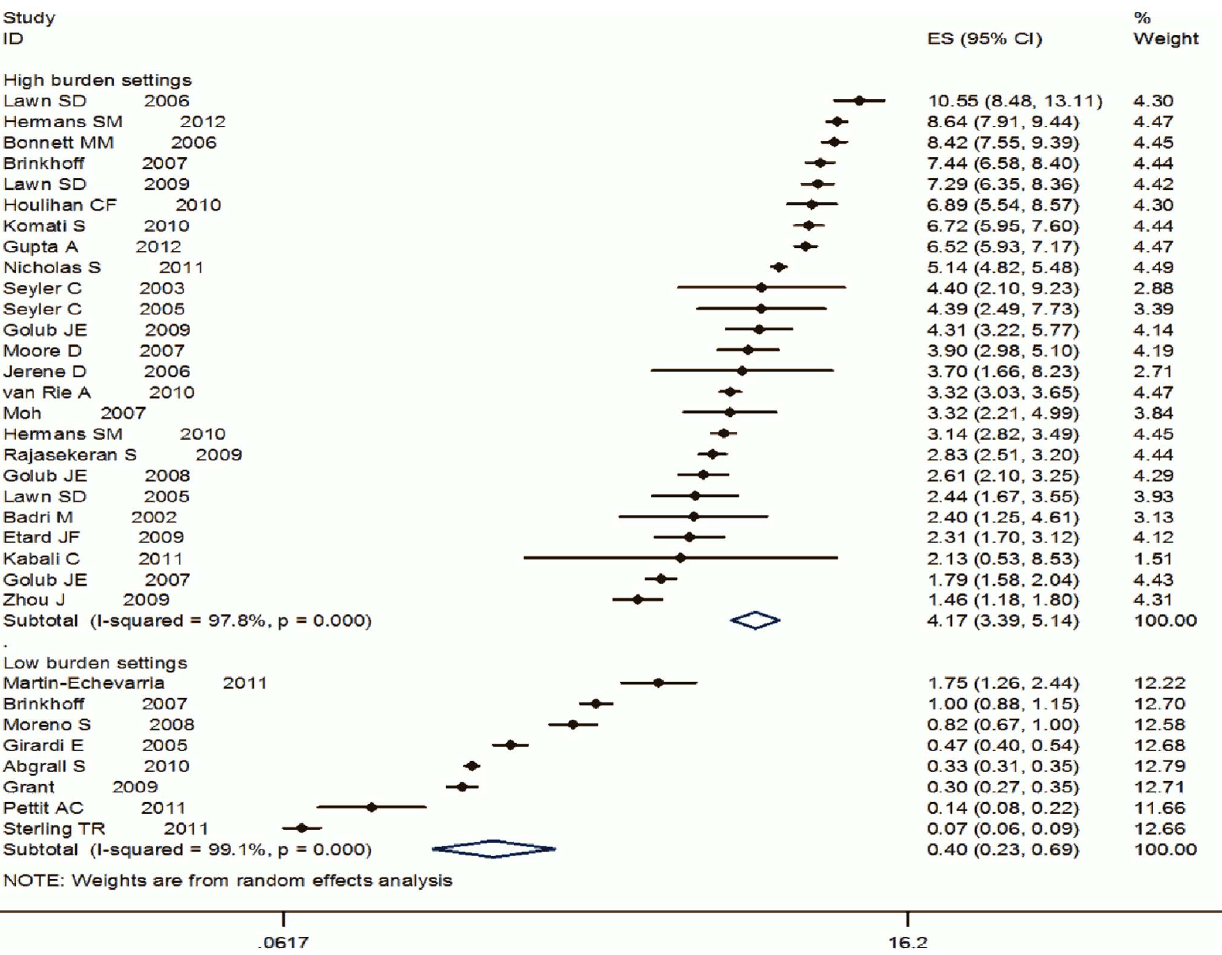
Figure 2. Forest plot showing summary estimates of TB incidence rates among individuals on cART comparing cohorts from high TB burden settings to low TB burden settings.